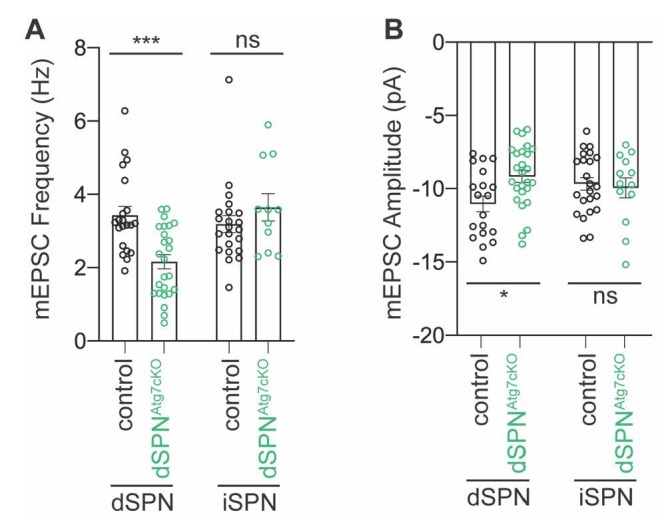
No change in mEPSC frequency or amplitude in iSPNs from dSPNAtg7cKO mice.mEPSCs were recorded from iSPNs in dSPNAtg7cKO mice and compared to control iSPNs. We show here that iSPNs from dSPNAtg7cKO mice have equivalent (A) mEPSC frequency and (B) mEPSC amplitude as iSPNs from control mice. Data from dSPNs arising from control or dSPNAtg7cKO mice are reproduced here for reference from Figure 3. Control iSPN data, also reproduced from Figure 3. Data are analyzed by two-way ANOVA followed by Bonferroni posthoc test. (A) Subtype x Genotype: F(1,75)=11.57, p=0.0011. (B) Subtype x Genotype: F(1,77)=4.444, p=0.0383. iSPNs from dSPNAtg7cKO mice: n=11,3. N for other group are the same as in Figure 3.